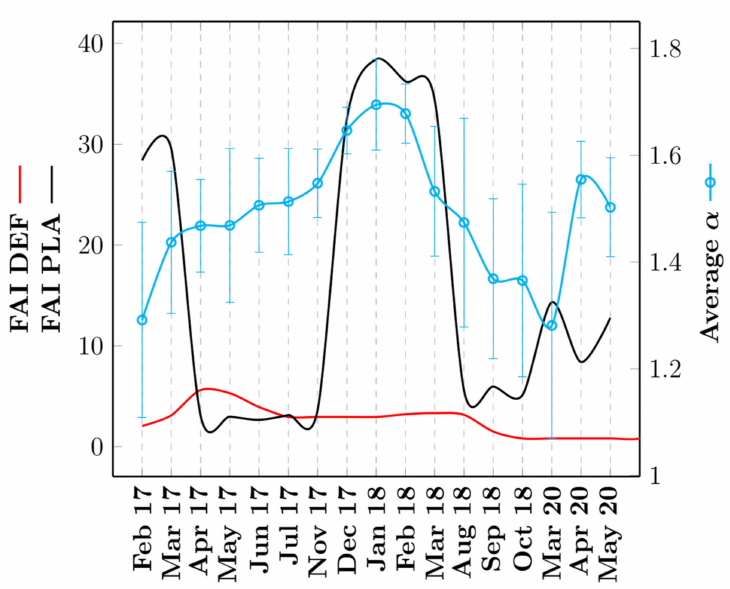
Figure 4. FAI and average α as a function of the different periods of monitoring of the troop. The red (resp. black) curve represents the FAI for the dry evergreen forest (resp. plantations) and is plotted along the left-hand y-axis. The cyan curve represents the variation of the average α and is plotted along the right-hand